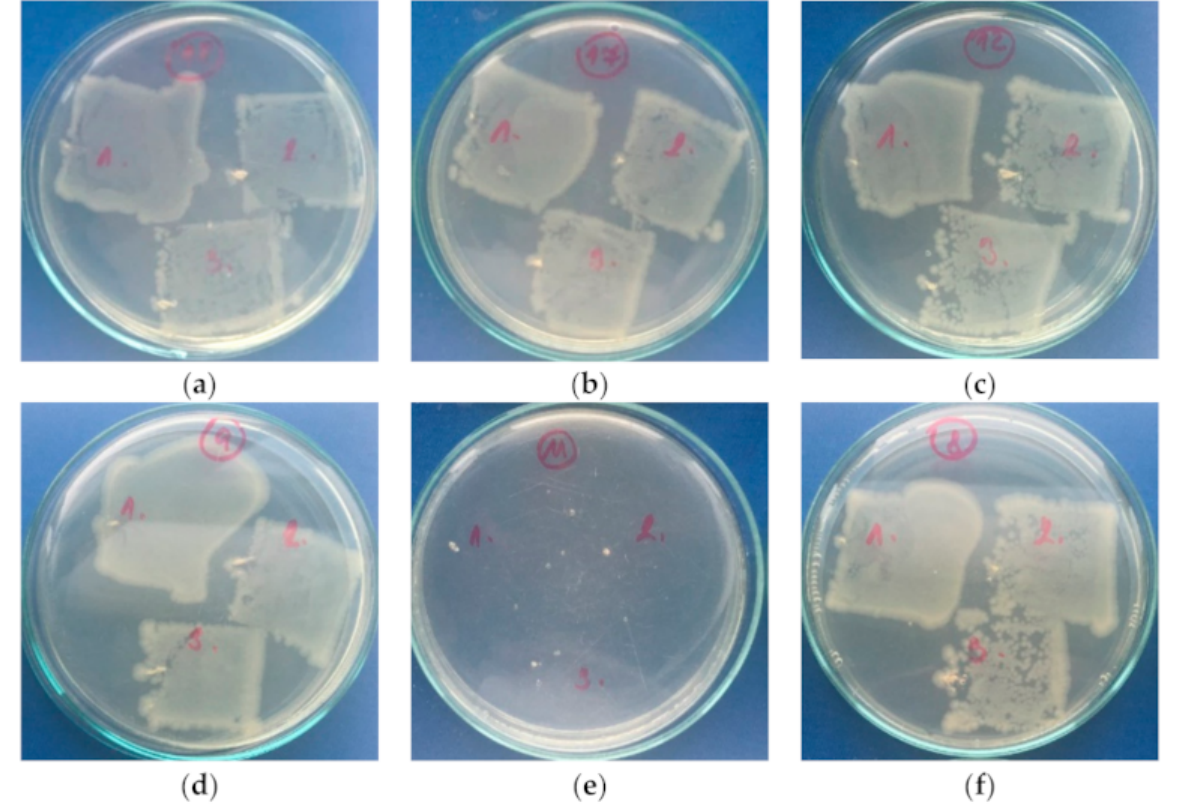
Figure 11. Total microbial counts on plate-count agar with inoculated Escherichia Coli : ( a ) PE, ( b ) PU, ( c ) PDMS/PA-PE, ( d ) PDMS/PA-PU, ( e ) PDMS/PA/BSO-PE, ( f )